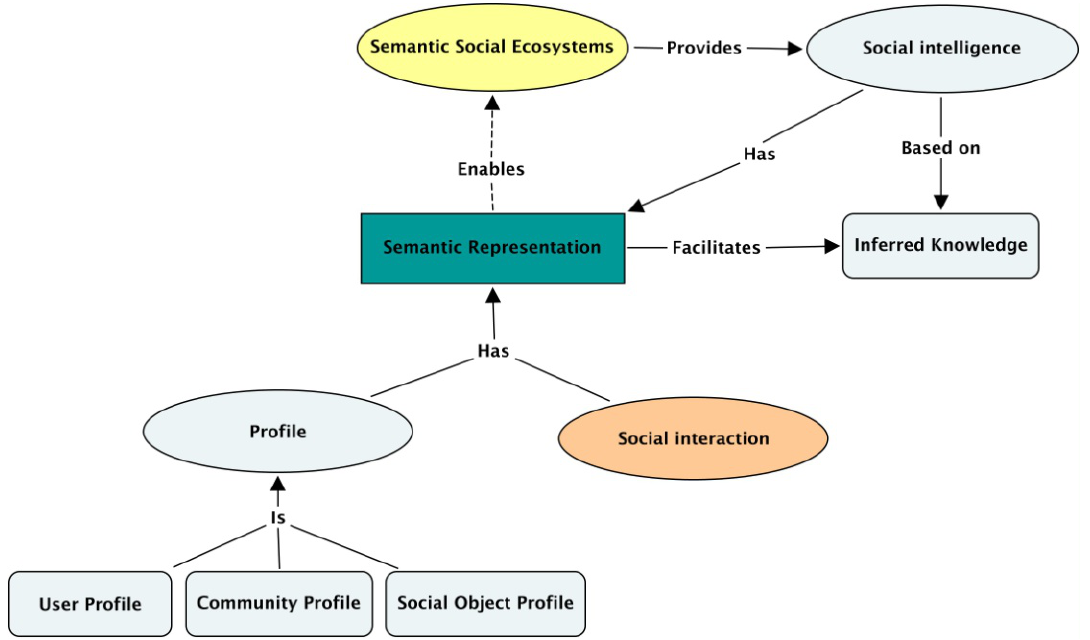
Figure 4. A light model for the Social Semantic Web by using concept